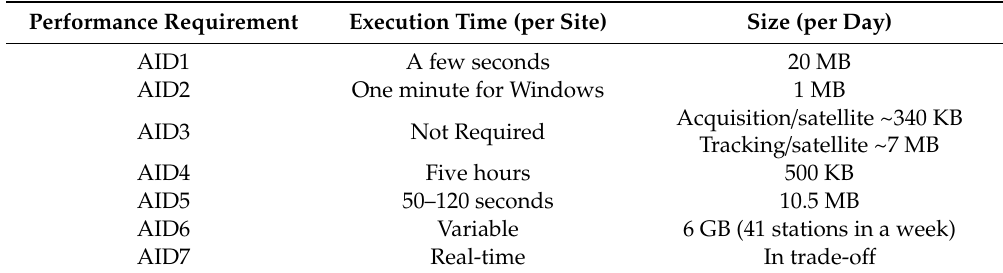
Table 4. Computational functionalities and performance